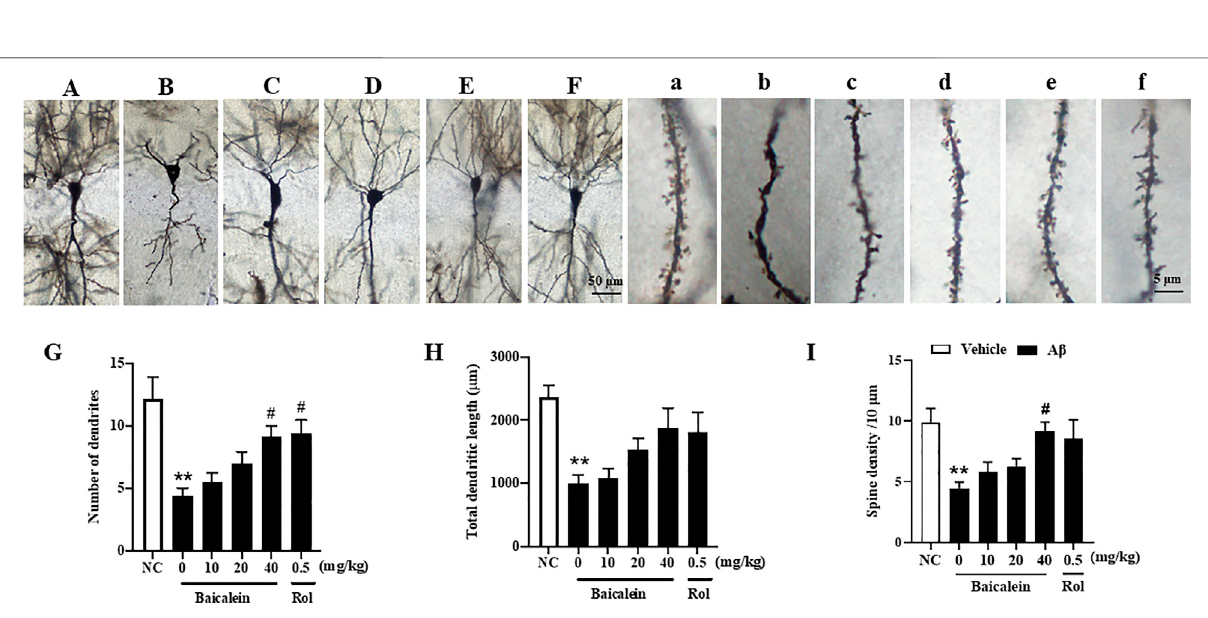
Frontiers in Pharmacology |